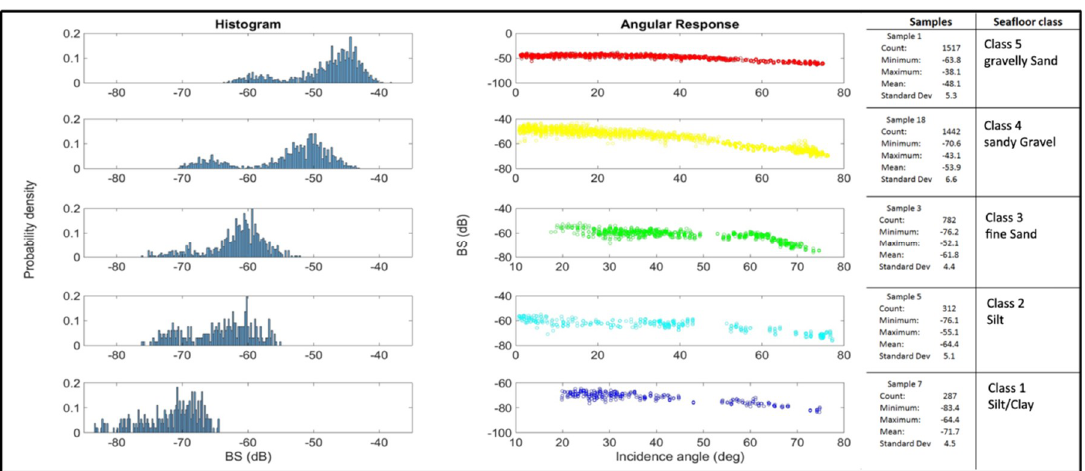
Figure 4. Angular responses of original soundings overlaid by ( a ) angular responses derived from cells of the interpolated HAC (iHAC), and ( b ) synthetic HAC (sHAC). ( c ) Superimposition of iHAC and sHAC angular responses. Colors symbolize each acoustic class that was characterized by the ground‐truth data in Table 1.